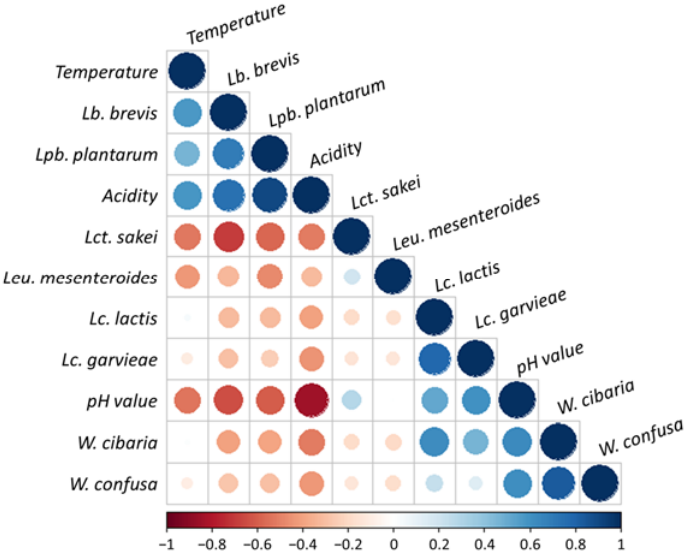
Figure 6. Pearson correlation matrix calculated from the relative abundance of major bacterial and environmental factors, such as pH, acidity, and fermented temperatures. The red and blue colors correspond to negative and positive correlations, respectively. The color intensity and circle size are proportional to the correlation coefficient. The color bar indicates the corresponding color and correlation coefficient.